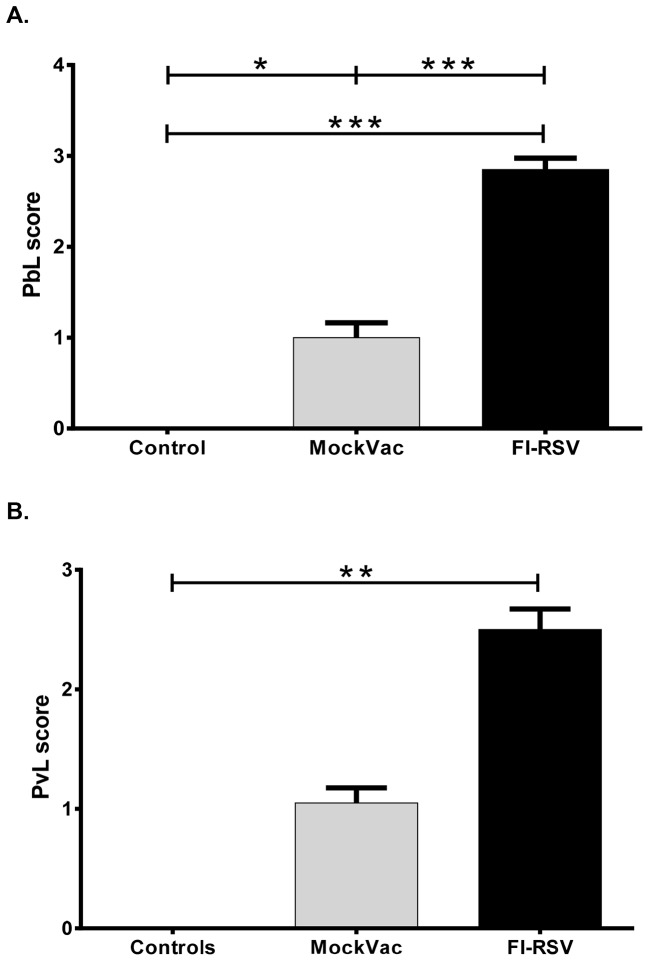
Extent of lymphocyte and plasma cell infiltrates into adventitia of bronchioles assessed by A. peribronchiolar lymphocytic (PbL) scores.FI-RSV-vaccinated lambs had significantly increased infiltrates compared to mock-vaccinated (MockVac) lambs. Controls lacked lesions. Extent of lymphocyte and plasma cell infiltrates into adventitia of blood vessels assessed by perivascular lymphocytic (PvL) scores (B). FI-RSV-vaccinated lambs had significantly increased infiltrates compared to control lambs. Mock-vaccinated lamb PvL infiltrates were not significantly different from control lamb levels. Controls lacked lesions. Control n = 4; MockVac n = 4; FI-RSV n = 4. Error bars = SEM, *P<0.05, ***P<0.001.